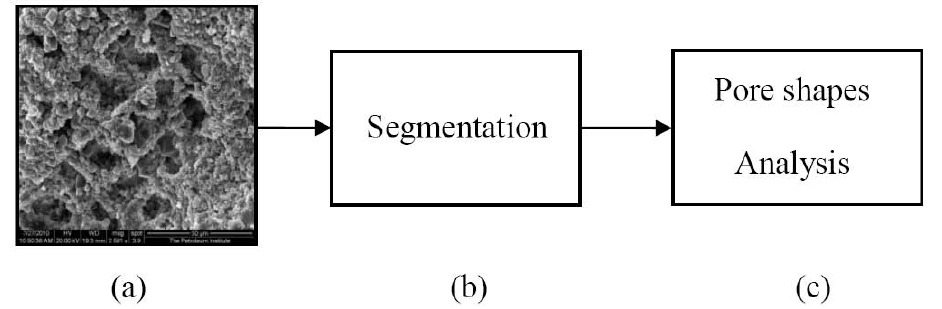
Fig. 1. Proposed workflow for pore spaces analysis: (a) Acquired SEM image, (b) Segmentation process based on a combination of statistical and spatial approaches, (c) Pore shapes analysis using multifractals and geometrical distributions of areas and aspect ratio.